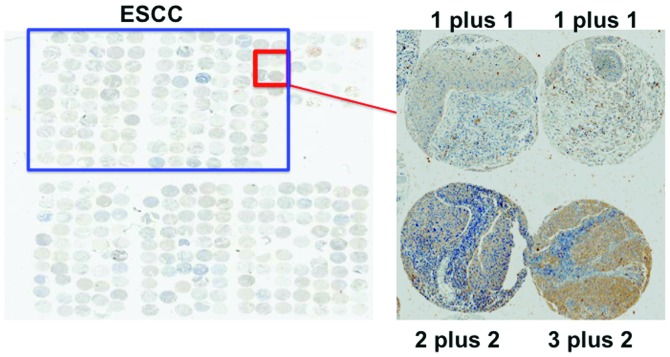
Deoxycytidine kinase (dCK) expression in the squamous cell carcinoma (SCC) tissue array. Out of 114 spots, 84 spots were considered evaluable for immunohistochemical analysis. The samples in the upper section of the inset (red) were diagnosed with a negative expression of dCK and those in the lower section of the window were diagnosed with a positive expression of dCK. ESCC, esophageal squamous cell carcinoma.